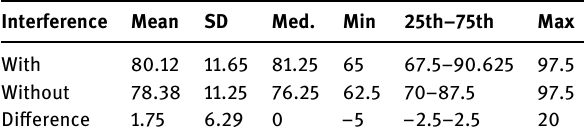
Table 3: SUS responses for the two repeated measures